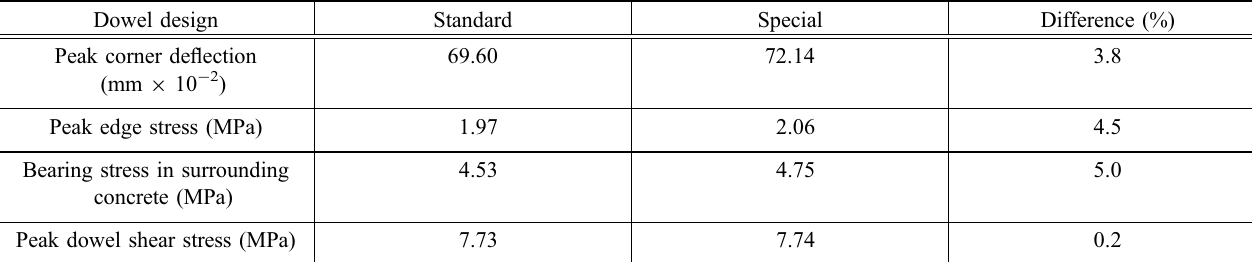
Table 4 Effects of different dowel bar arrangements on deflections and